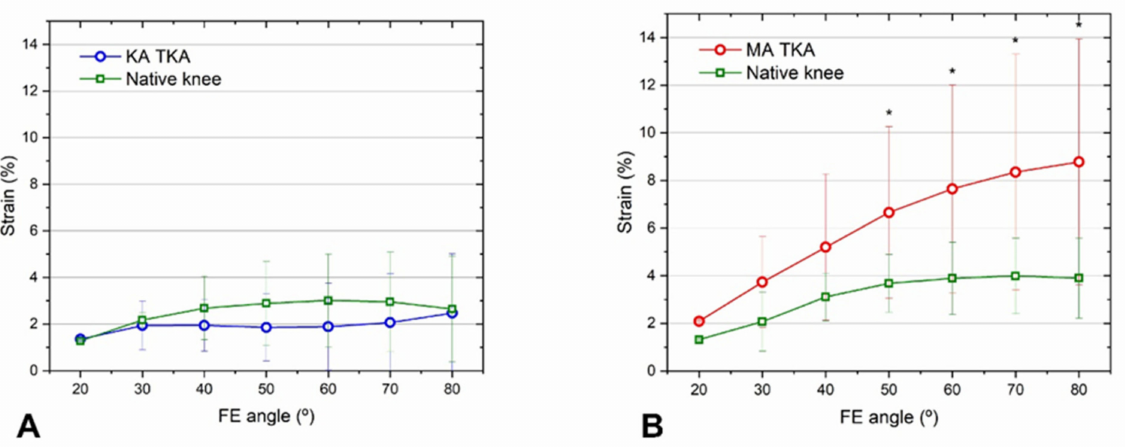
Figure 7. MCL strain after KA TKA ( A ) and MA TKA ( B ). The mean strains following KA TKA and that of the native knee were consistently similar, while the mean strain after MA TKA was about two-fold higher at >30 ◦ of flexion. Error bars denote standard deviations. Significant differences ( p < 0.05) are marked with